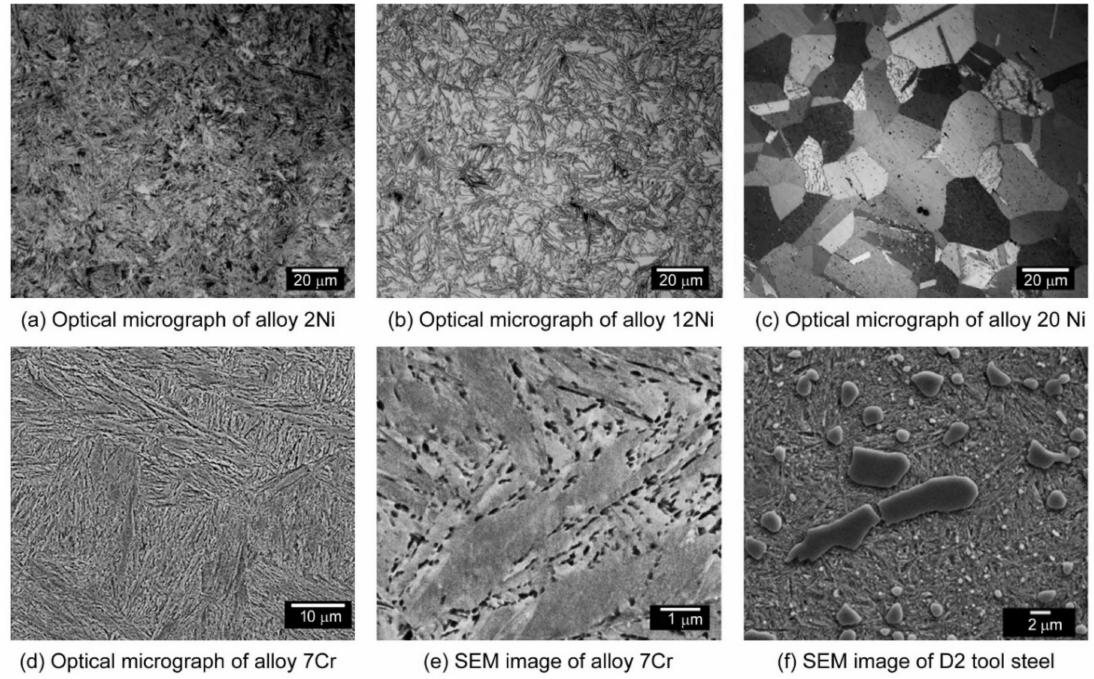
Figure 1. Microstructures of selected alloys from the present study. ( a ) Optical micrograph of martensitic 2Ni alloy. ( b ) Optical micrographs of mixed austenite and martensite microstructure in 12Ni alloy. ( c ) Optical micrograph of austenitic 20Ni alloy; note that the small black dots are an etching artefact. ( d , e ) Martensitic structure of 7Cr alloy, black dots in ( e ) result from etching. ( f ) Carbides and martensite in D2 tool steel. Note higher magnification in ( e , f ).